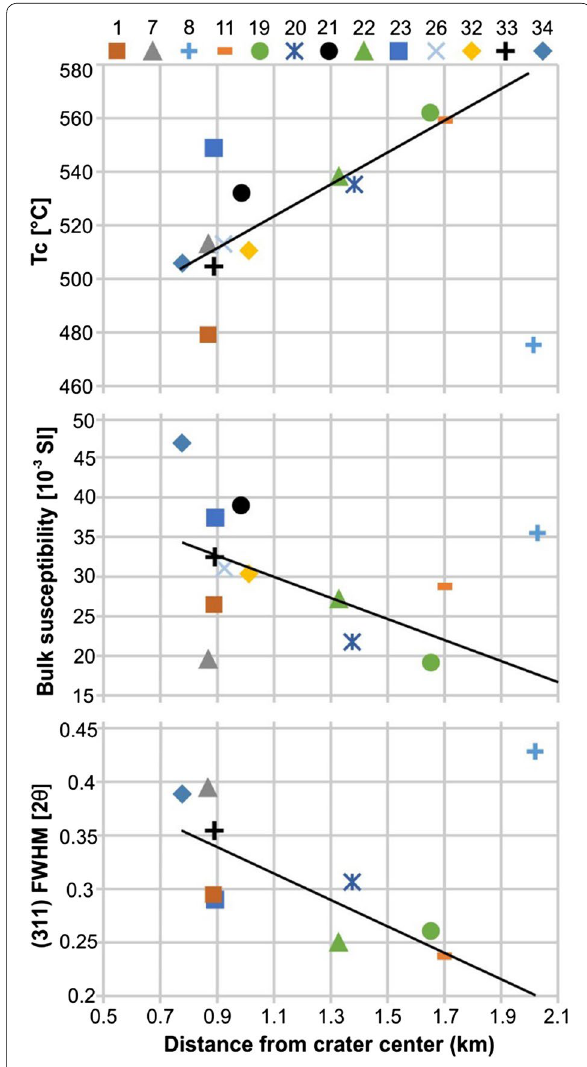
Fig. 4 Variation in T C , bulk magnetic susceptibility and FWHM with the distance from the crater center. Note that the black trend line is calculated by excluding sample